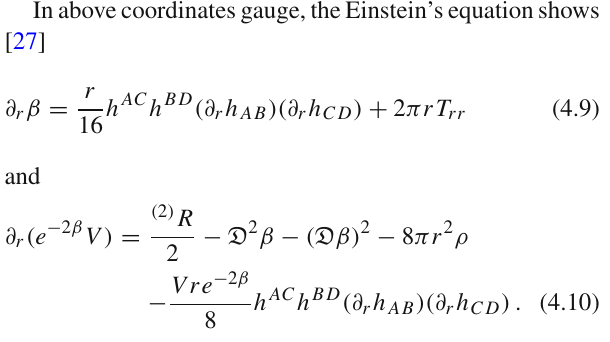
Fig. 3 Left: the outgoing null rays of photon sphere form the null sur- face u = 0. A photon sphere S locates at an equal- t spacelike surface as well as locates at a null sheet. On the null sheet, the photon sphere then is defined by r = r S ( x A ) . Right: the null foliation of spacetime.